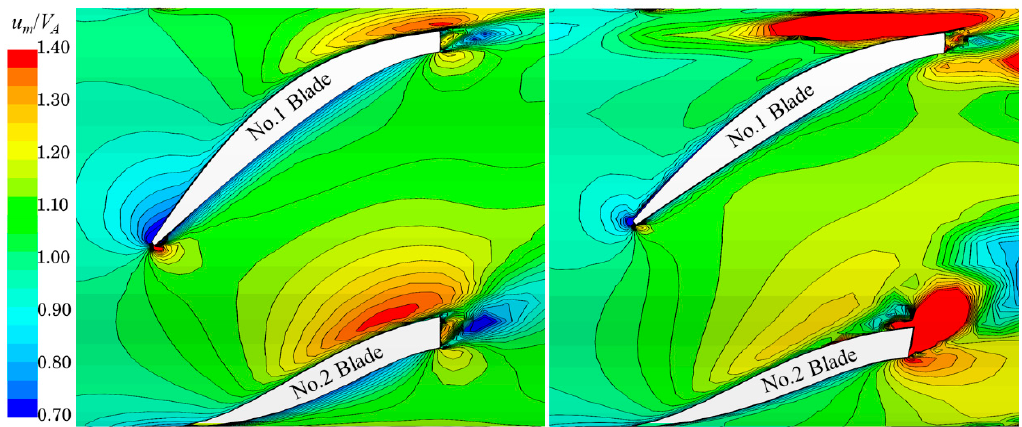
Figure 21. Comparison of dimensionless velocity contours near Blade No. 1 at 0.4 R and J = 1.4 ( left : horizontal flow; right : oblique flow).